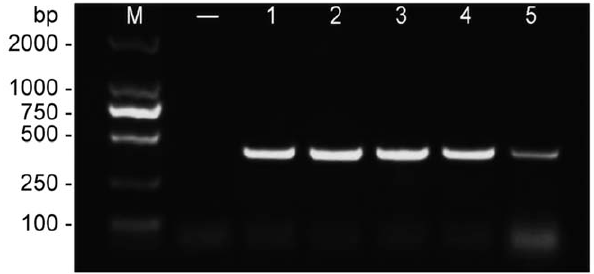
Figure 8. Detection of the viral RNA from clinically infected duck samples. Infection in duck brain tissues collected from different regions was assessed using RT-PCR with BYDV E gene-specific primers. -: negative control; 1,2,3,4 and 5: samples from Hebei, Jiangxi, Jiangsu, Beijing and Shandong provinces. These PCR products were sequenced and their identities were confirmed.